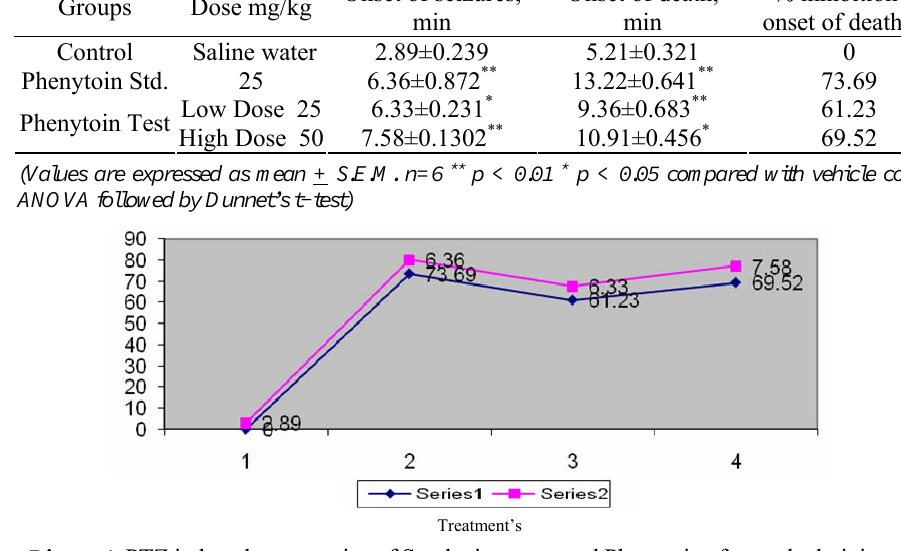
Figure 4. PTZ induced test on mice of Synthetic compound Phenytoin after oral administration